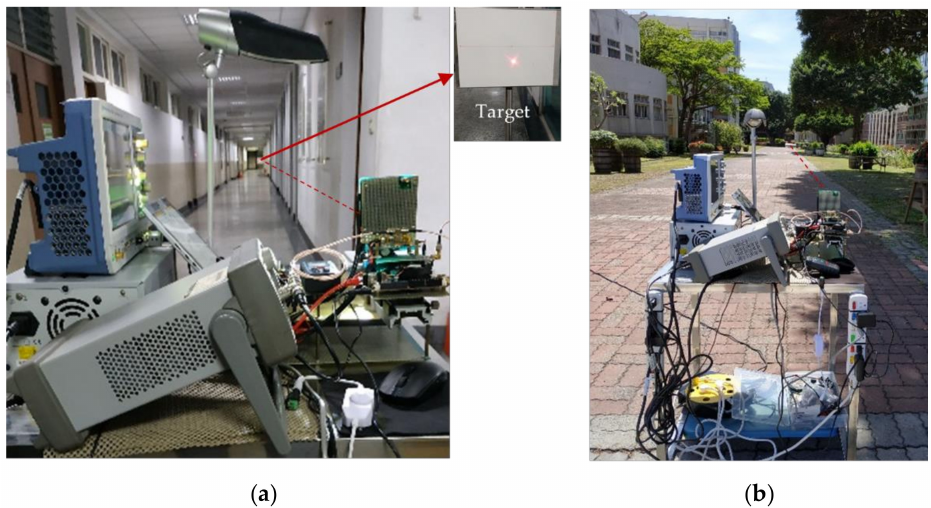
Figure 13. Photographs of the experimental setup: ( a ) in the laboratory at night; ( b ) outdoor at